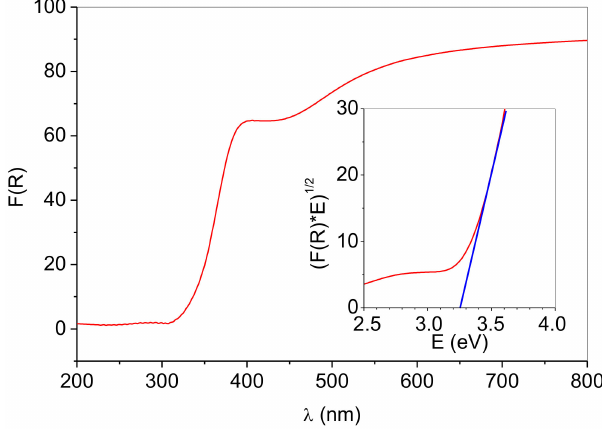
Figure 7. Diffuse reflectance UV–Vis spectra of the prepared photocatalyst. Insets: Tauc’s plots for indirect (n = 1/2) transition.